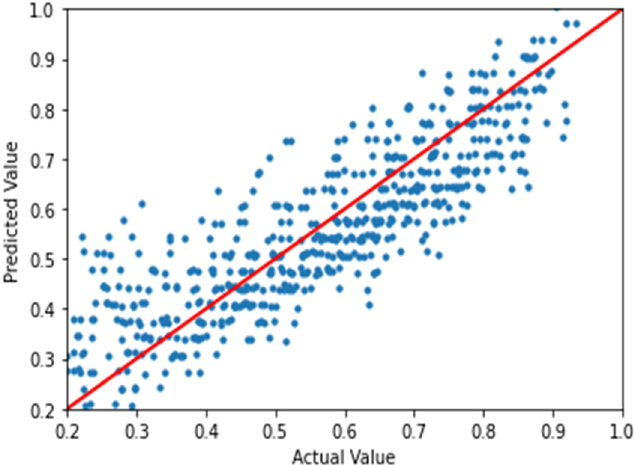
Figure 4. Simulated vs. predicted values of the coverage probability with a trend line. Table 6. Evaluation of the finalized models.